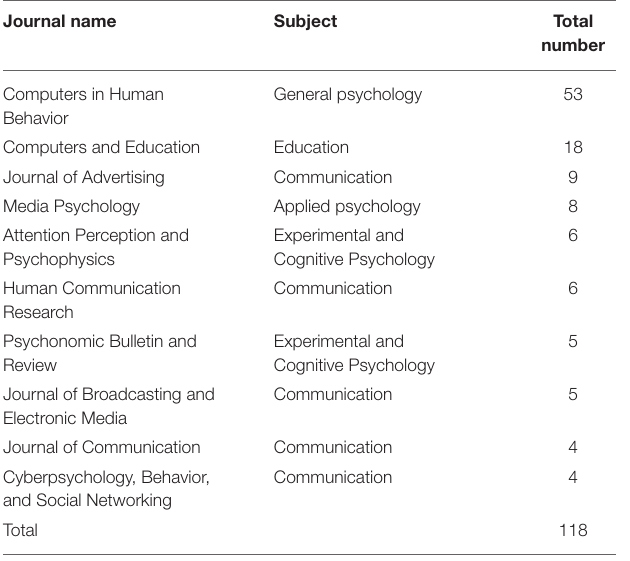
TABLE 1 | The ten most productive journals contributing to media multitasking research.